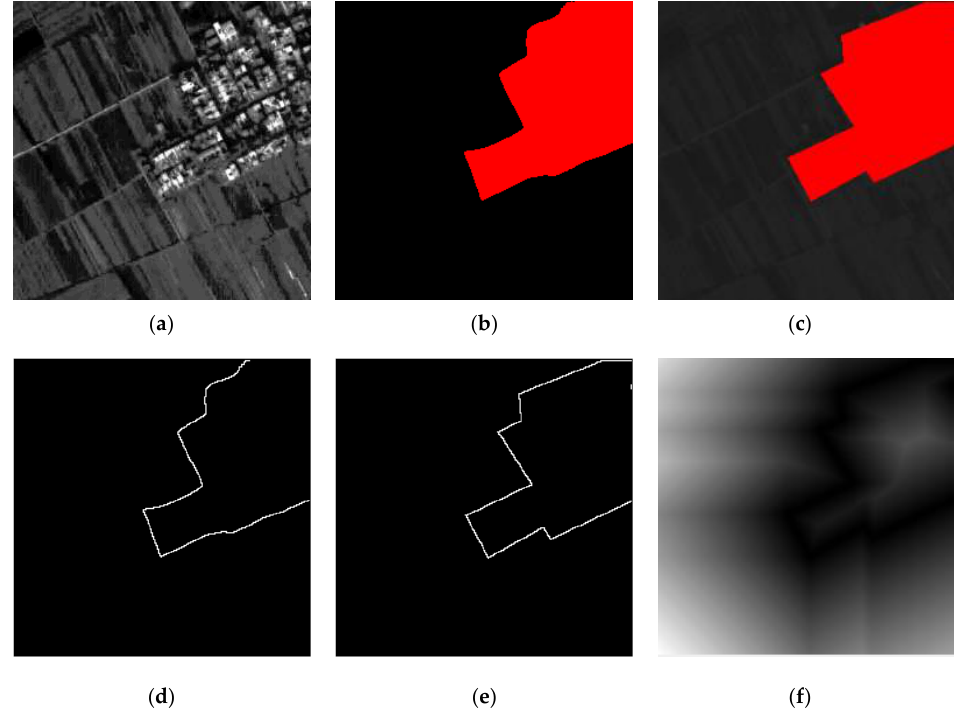
Figure 8. Schematic illustration of the procedure used to calculate the CMI: ( a ) Image; ( b ) model prediction image; ( c ) label image; ( d ) contour image of ( b ); ( e ) contour image of ( c ); and ( f ) transformed image of ( e ).